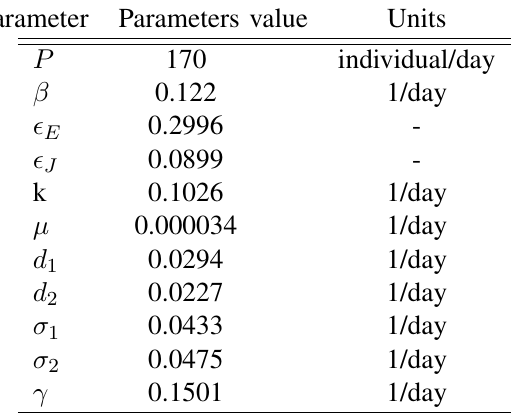
TABLE II: Model parameter